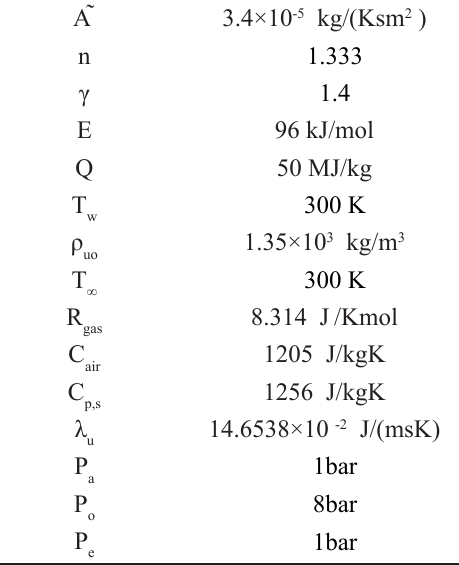
Table. 1. The values of adjusting